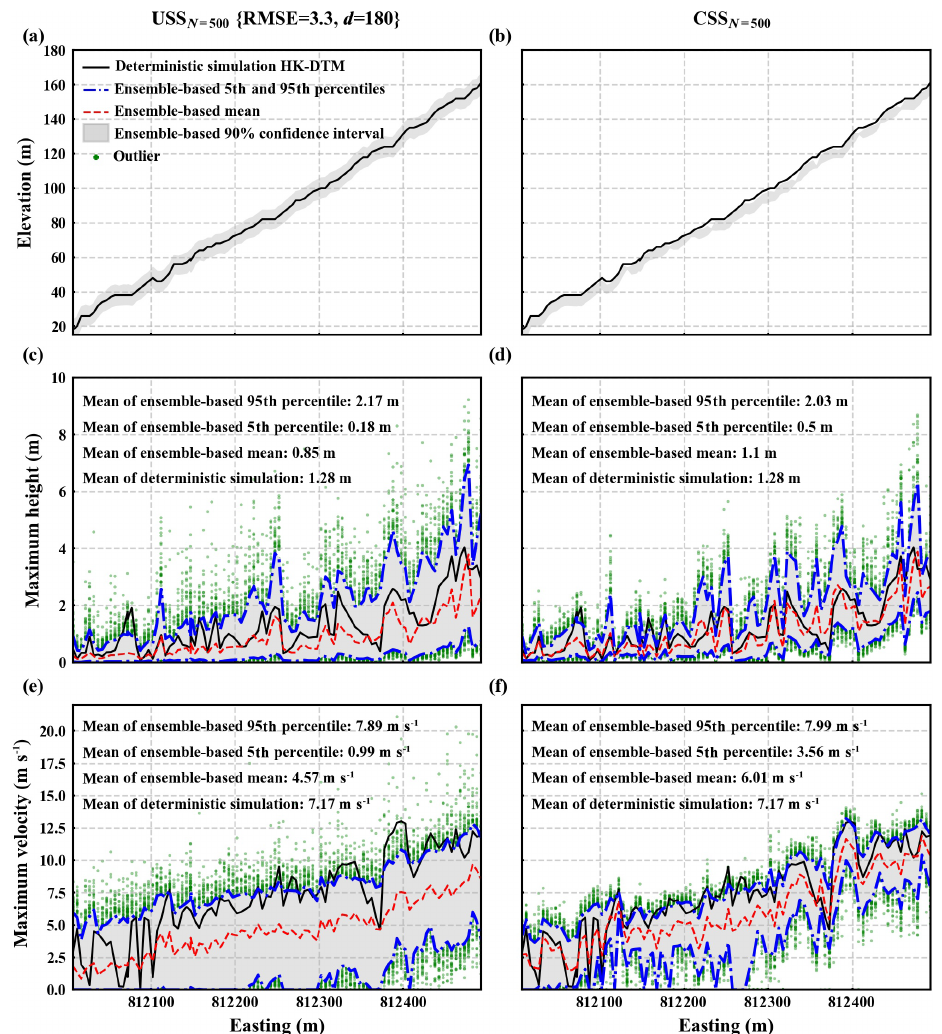
Figure 9. Elevation, maximum height, and maximum velocity at locations along the channel bottom (see Fig. 7b). Panels (a) , (c) , and (e) correspond to the USS N = 500 {RMSE = 3 . 3, d = 180} ensemble and panels (b) , (d) , and (f) to the CSS N = 500 ensemble. In each panel, dash-dotted blue lines represent the ensemble-based 5th and 95th percentiles of the quantity. The dashed red line represents the ensemble- based mean of the quantity. The black line denotes corresponding results of the deterministic simulation. Annotated mean values are an average of all the locations. Ensemble-based flow dynamic properties largely vary from deterministic simulation results. The variation range of the USS N = 500 {RMSE = 3 . 3, d = 180} ensemble is larger, while its ensemble-based mean is smaller, compared to counterparts of the CSS N = 500